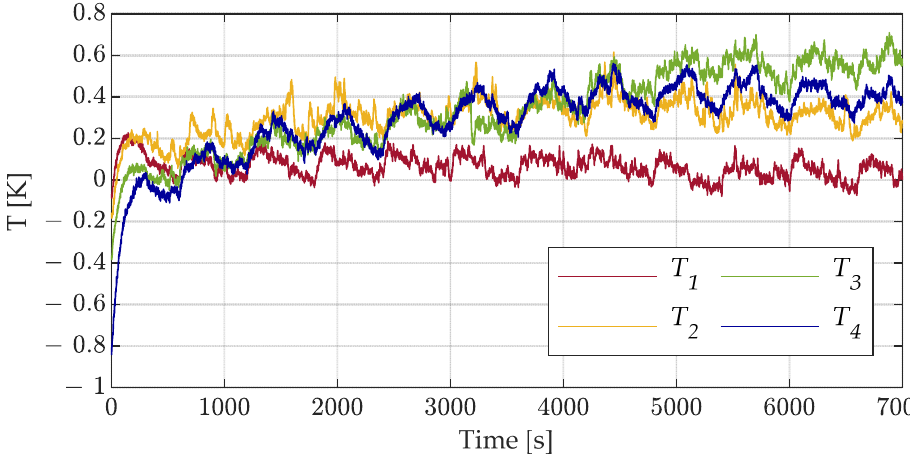
Figure 18. Error test three cells 30 A.